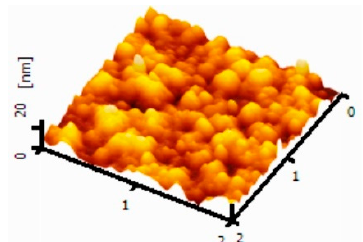
Figure 5. Tapping-mode atomic force microscopy (AFM) height images of the DBR film. The scan area of the image is 2 × 2 μ m.